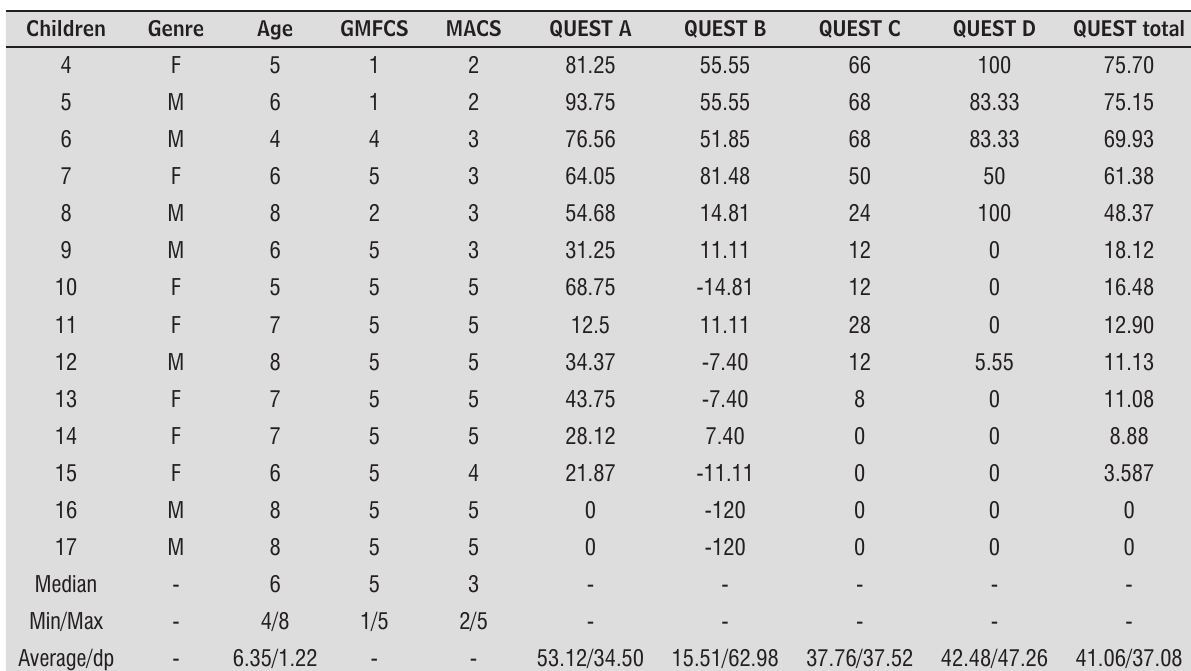
Table 1 - Sample characterization and assessment tools